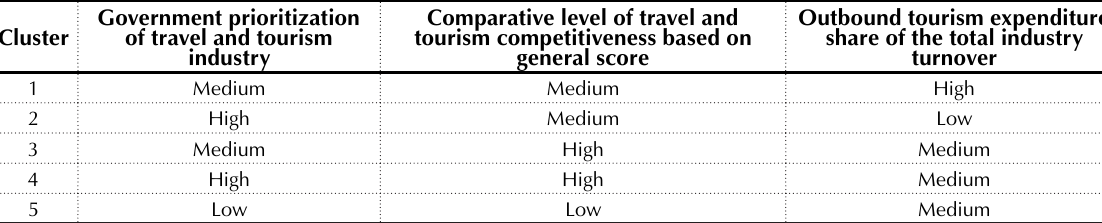
Table 4. The average characteristics of the grouping indicators Cluster